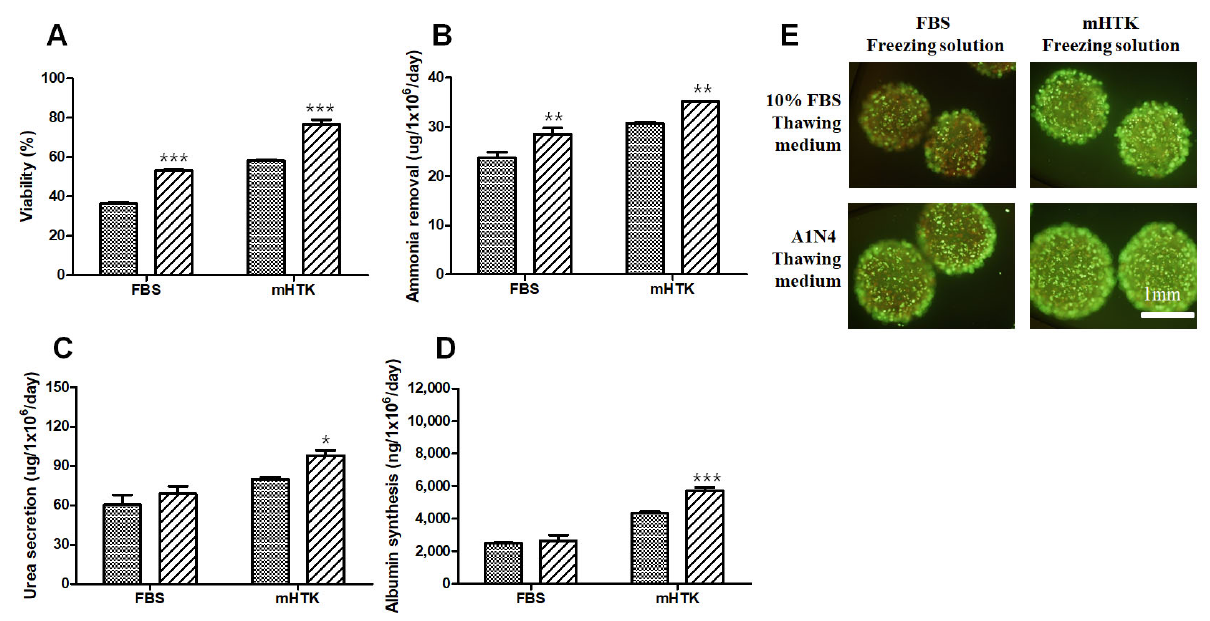
Figure 7. Effects of freezing and thawing solutions on the viability and liver ‐ specific functions of porcine hepatocyte spheroid beads in the post ‐ thawing culture. Porcine hepatocyte spheroid beads were cryopreserved in two different freezing solutions supplemented with 15% DMSO and stored for 1 year in liquid nitrogen. Porcine hepatocyte spheroid beads were warmed rapidly using a water bath and washed twice in a thawing medium (warm serum medium (10% FBS,